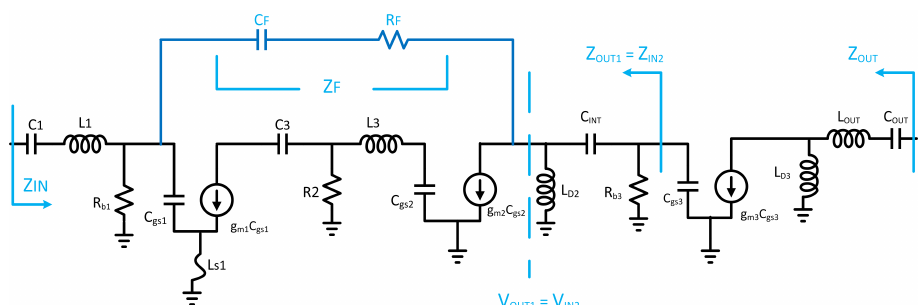
Figure 3. Small signal-equivalent circuit